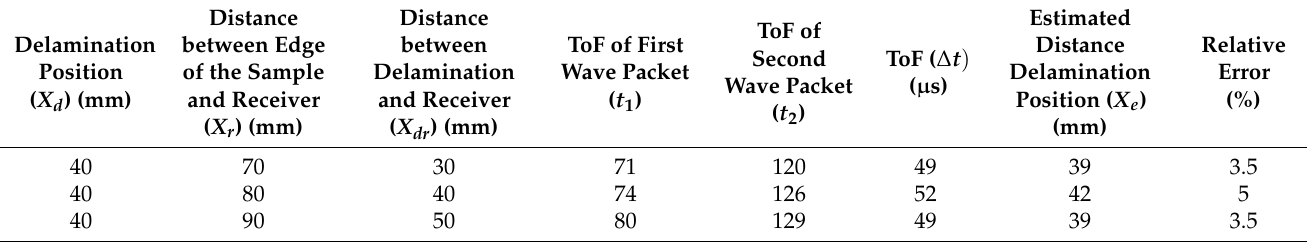
Table 7. The localization of delamination at 120 mm using CWT.